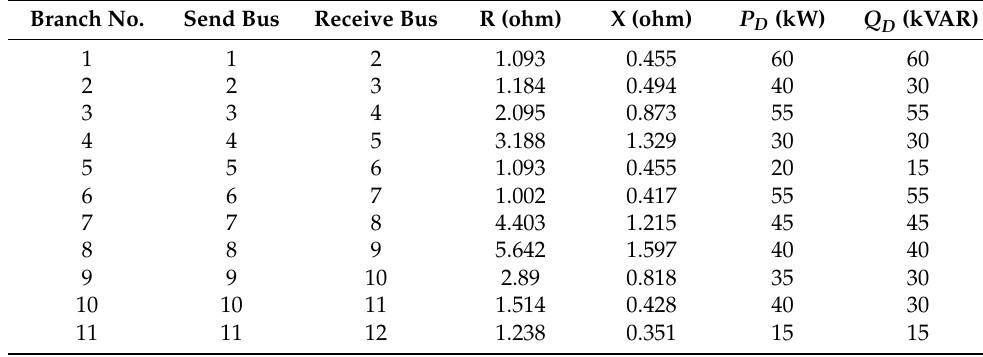
Table A1. The data bus and line data of the 12-bus system. Branch